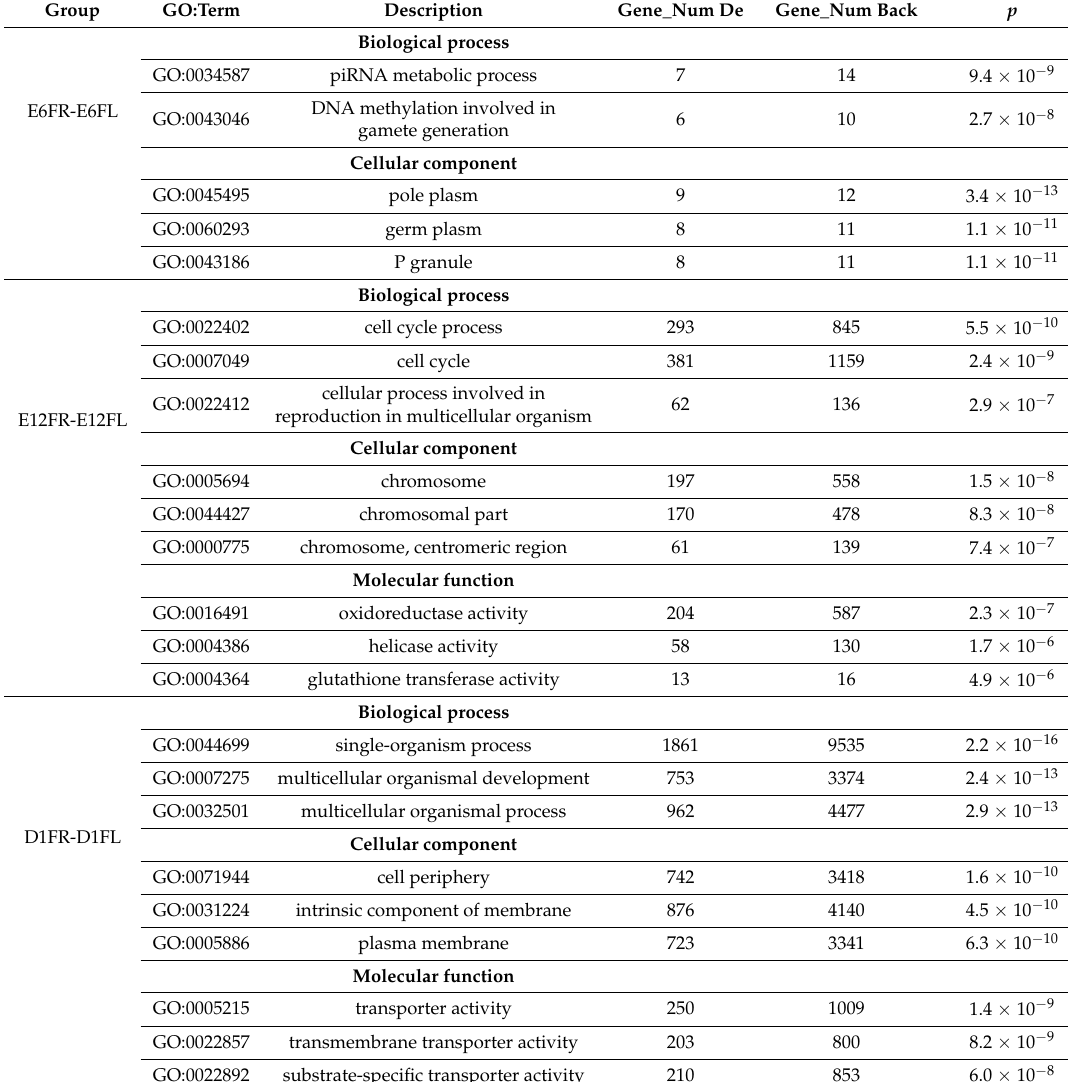
Table 2. The most significantly affected gene ontology (GO) terms between right and left ovaries.